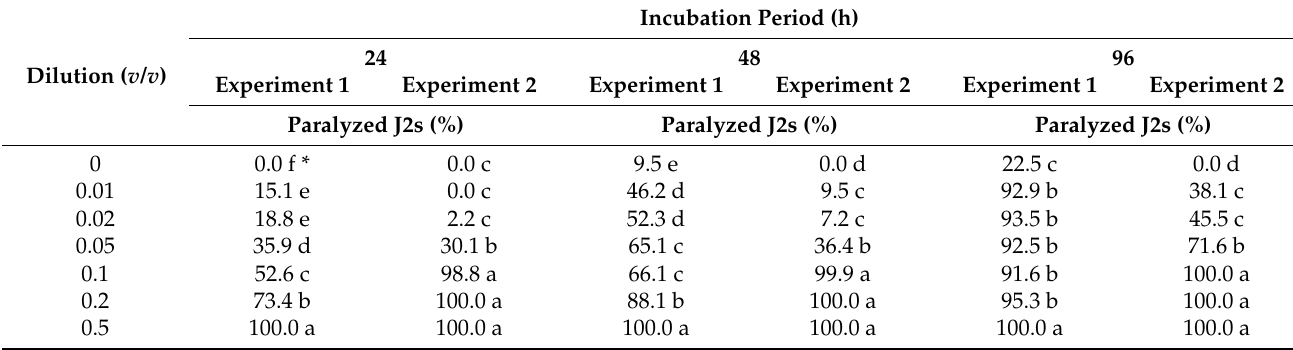
Table 4. Motility percentages of Meloidogyne incgonita J2s after immersion in Cuminum cyminum seed hydrosol at 0, 0.01, 0.02, 0.05, 0.1, 0.2, and 0.5 v/v concentrations for 24, 48, and 96 h exposure times.